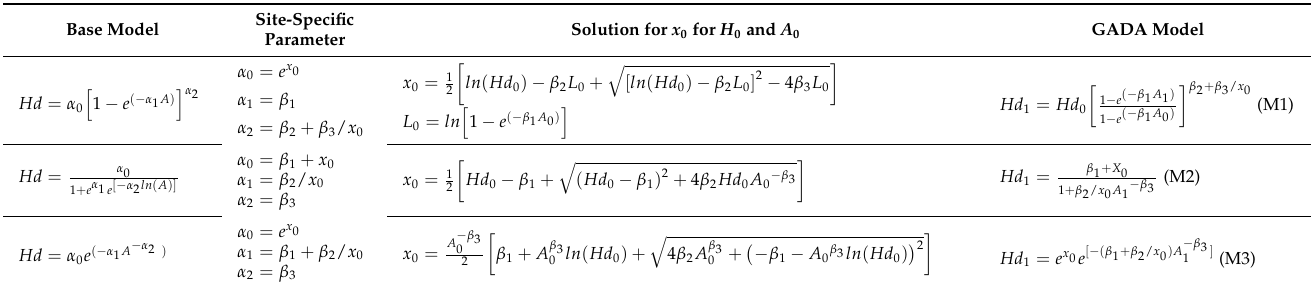
Table 2. Base growth equation and GADA formulations fitted to combined datasets. Base Model Site-Specific Parameter Solution for x 0 for H 0 and A 0 GADA